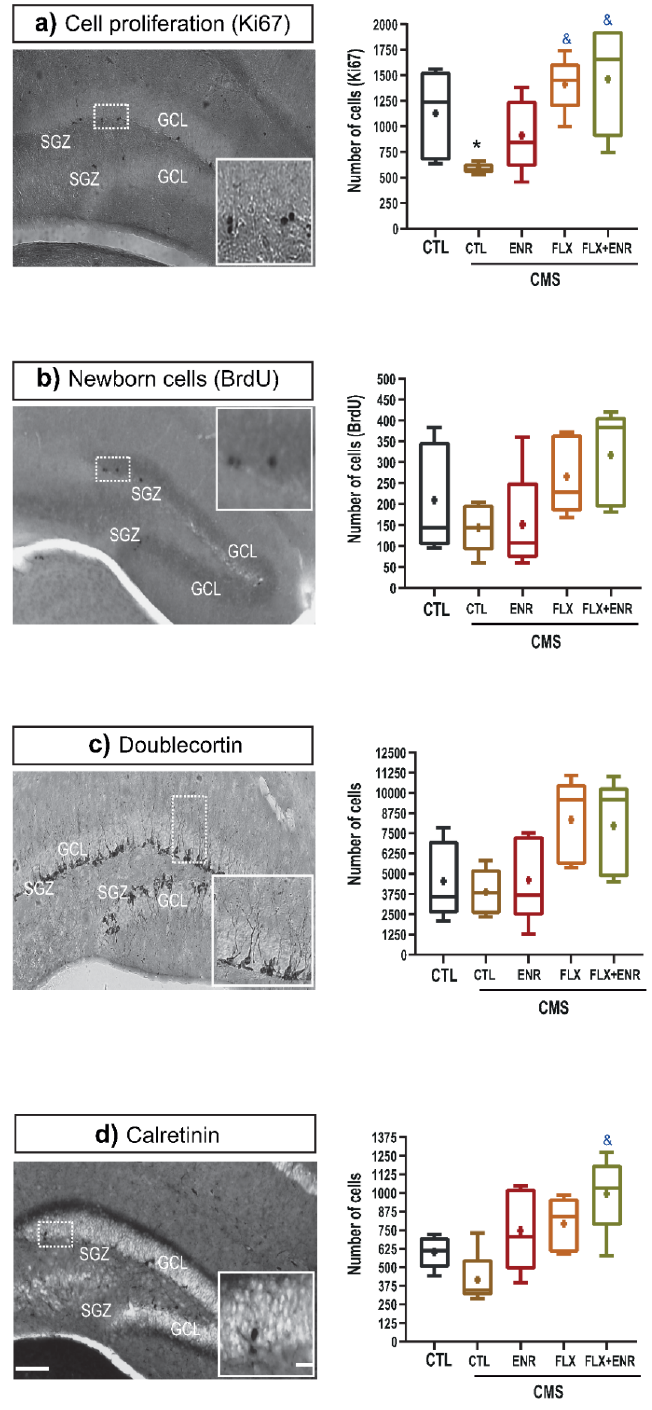
Figure 3. Chronic mild stress (CMS) decreases hippocampal neurogenesis (CTL-CMS) compared with unstressed mice (CTL). Environmental enrichment (ENR), fluoxetine (FLX), or their combination (FLX + ENR) reverses the decreased neurogenesis caused by chronic stress. ( a – d ) Representative mi- crographs of proliferative cells, expressing Ki-67, BrdU, doublecortin or calretinin cells. Micrographs also show the granule cell layer (GCL), molecular layer (ML), and subgranular zone (SGZ). Scale bar = 200 µ m. Inserts show amplification. Scale bar = 15 µ m. Quantification of Ki-67-labeled cells shows that CMS significantly decreased the number of this cellular population. However, the effects of CMS were reverted by some of the treatments ( n = 5). Data represent the mean ± standard error of the mean (SEM). Symbols “&” or “*” in ( a , d ) indicate p ≤